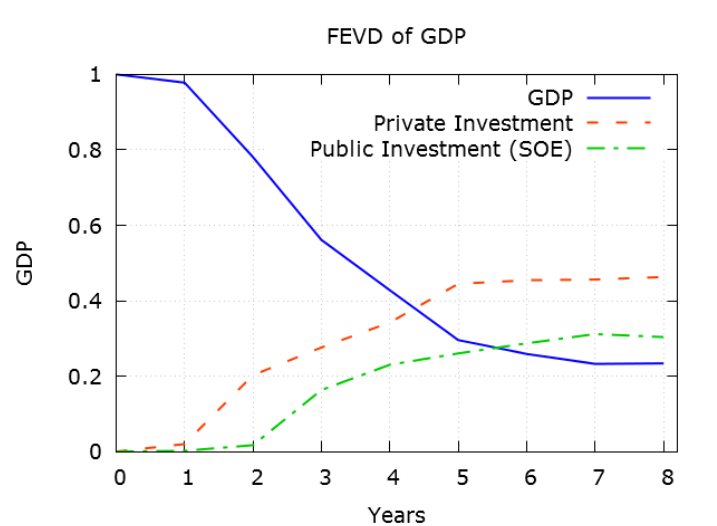
Figure 5 : Variance decomposition of GDP, industrial investment (SOE)